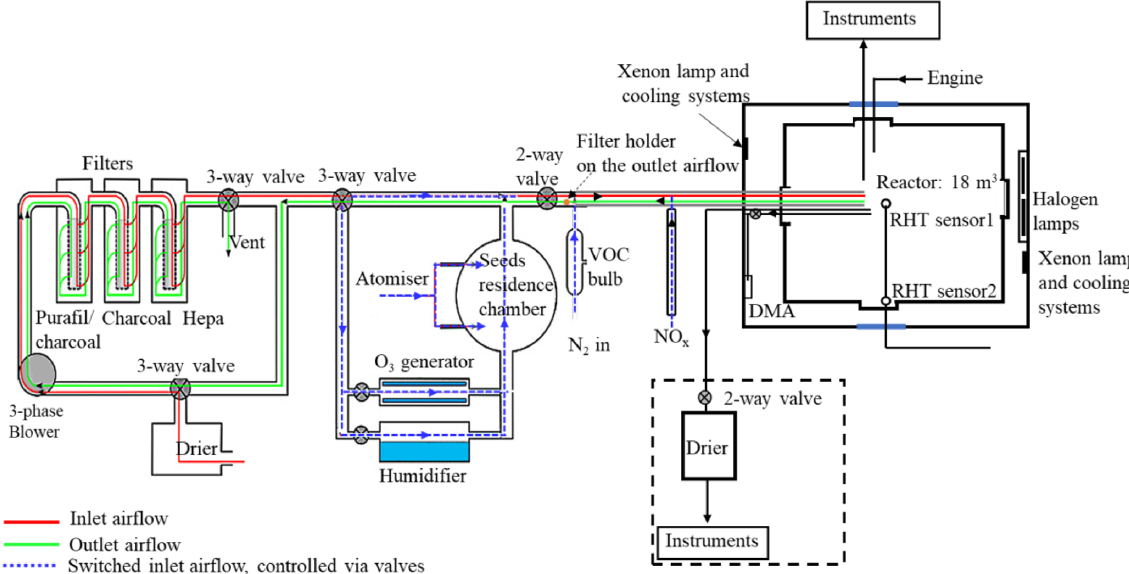
Figure 1. Schematic of the Manchester Aerosol Chamber